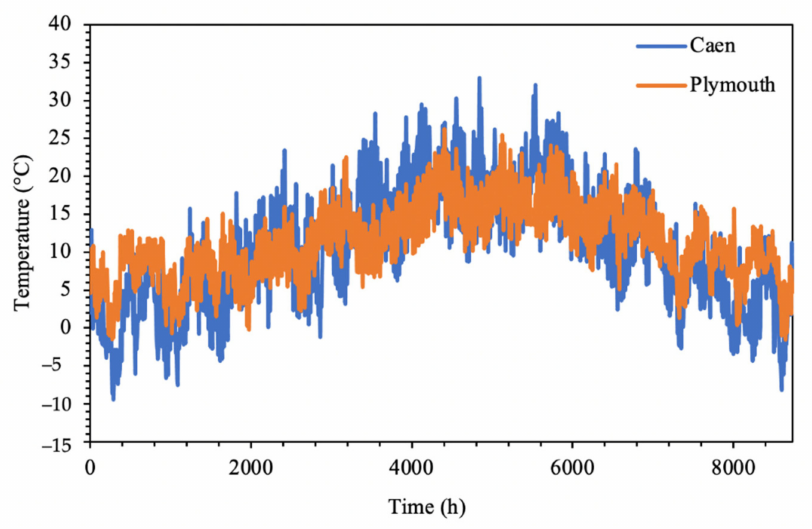
Figure 17. Mean outdoor temperature over ten years in Caen and